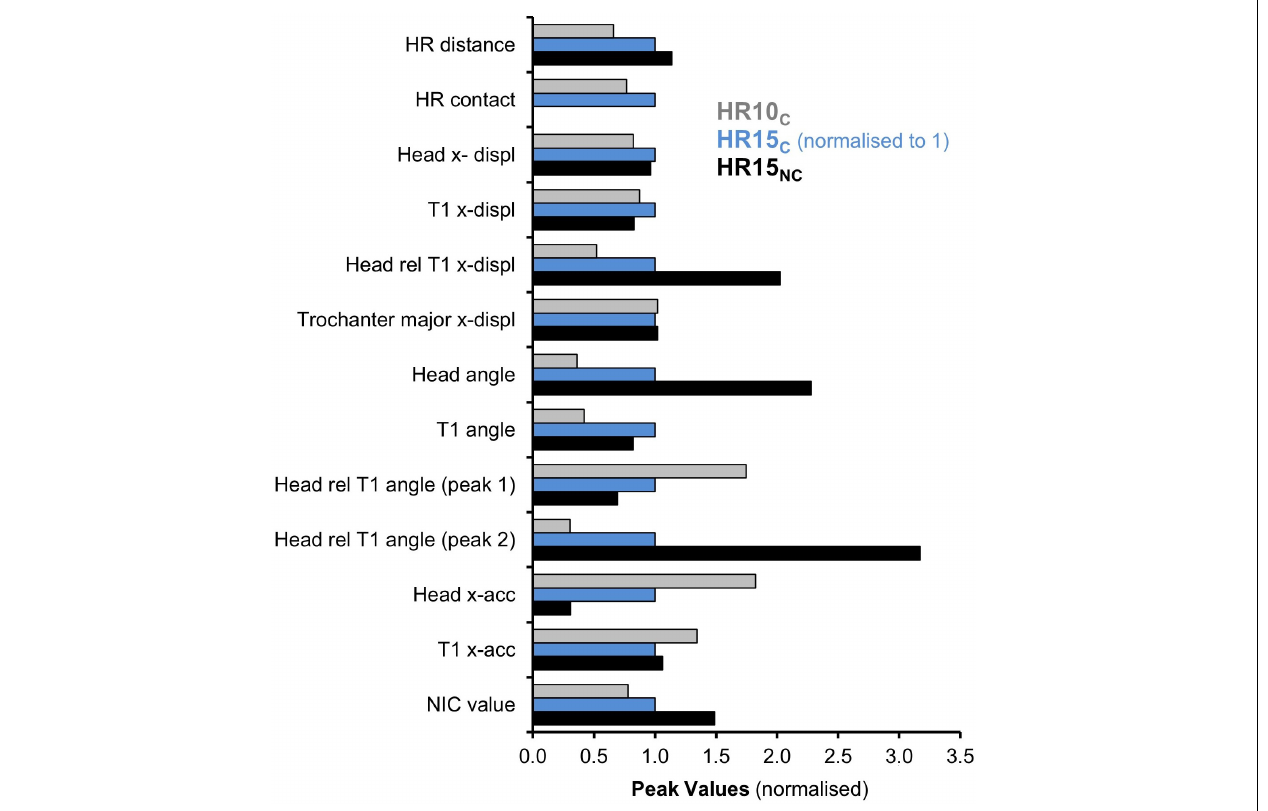
FIGURE 7 | The relative HR distance and contact time; peak x-displacements (head, T1, head relative to T1, trochanter major); angular displacements (head, T1, head relative to T1); x-accelerations (head, T1) and NIC value for HR10 C , HR15 C (normalised to 1) and HR15 NC